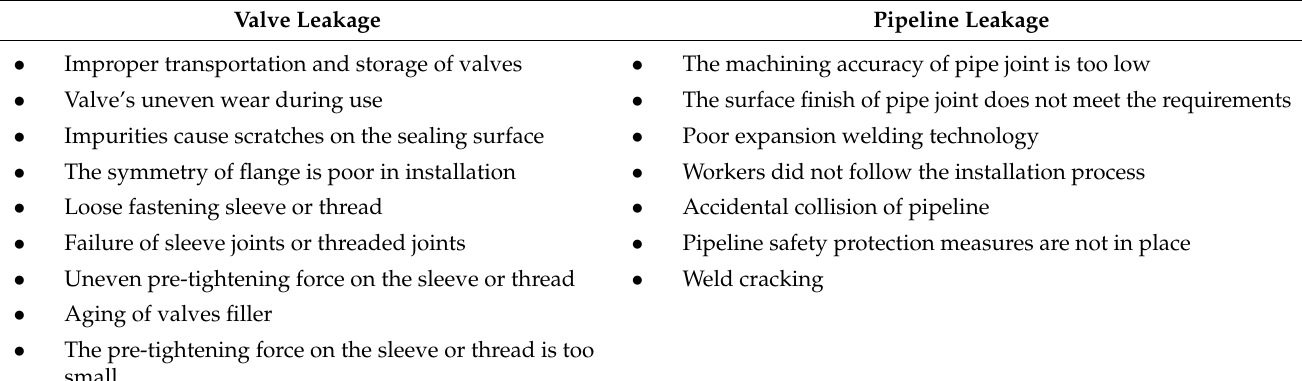
Table 2. Reasons for hydrogen leakage in hydrogen gas supply system.